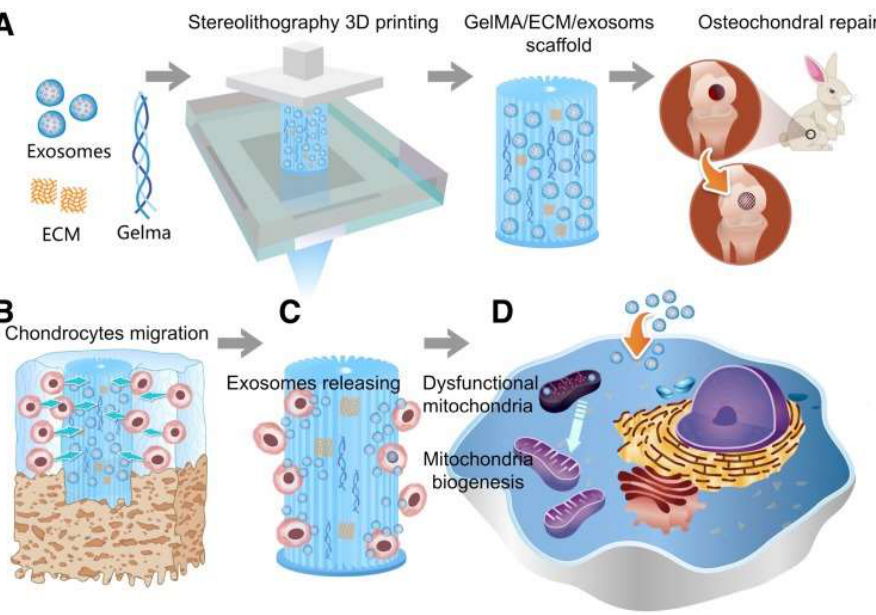
Figure 3. Schematic illustration of the one-step operation system for facilitating osteochondral defect regeneration. ( A ) Stereolithography-based bioprinting and osteochondral defect implantation. ( B ) Migration of chondrocytes to the defect regions. ( C ) Controlled administration of exosomes by the 3D printed scaffolds. ( D ) Enhanced chondrocyte mitochondrial biogenesis by the scaffolds [158].